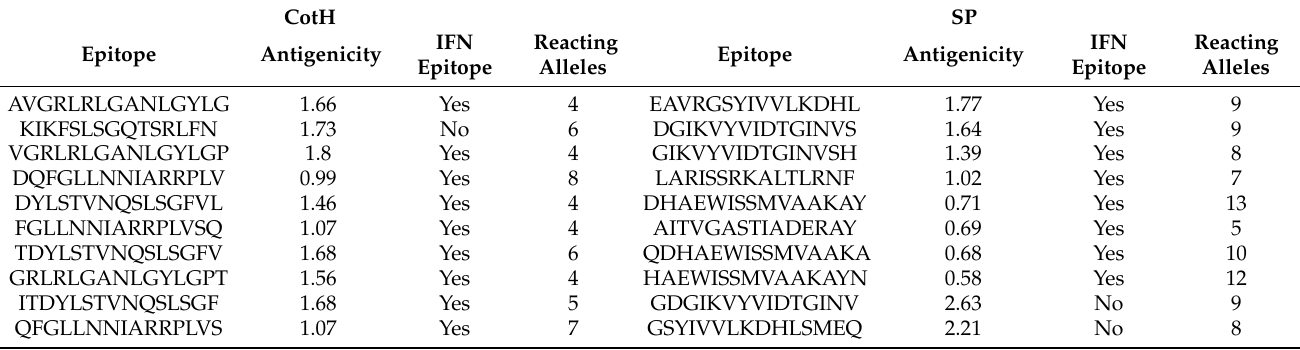
Table 4. Filtered MHC-II peptides of CotH and SP